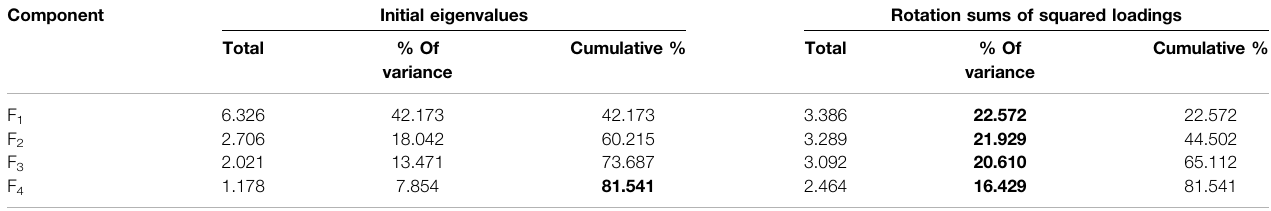
TABLE 3 | Extracted principal components and total variance